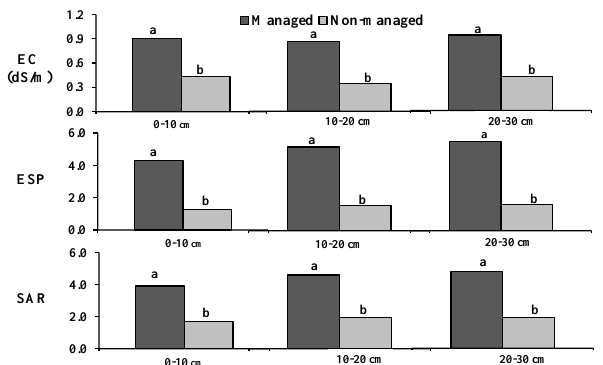
Figure 2: Differences in selected soil chemical properties examined within depths between Figure 2. Differences in selected soil chemical properties exam- managed and non-managed zones of all seven golf courses examined in Lubbock, Texas, USA (n ined within depths between managed and non-managed zones of = 7). Mean values within a soil depth with the same letter are not statistically different (Fisher's all seven golf courses examined in Lubbock, Texas, USA ( n = 7). LSD, α = 0.05). EC, Electrical Conductivity; ESP, Exchangeable Sodium Percentage; SAR, Sodium Adsorption Mean values within a soil depth with the same letter are not sta- Ratio. tistically different (Fisher’s LSD, α = 0.05). EC is electrical con- ductivity; ESP is exchangeable sodium percentage; SAR is sodium adsorption ratio.